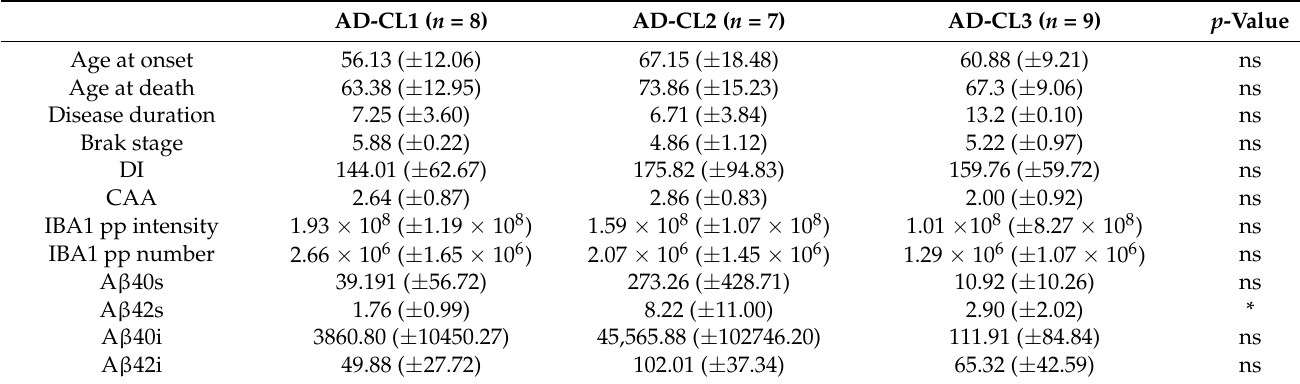
Figure 6. ( a ) Hierarchical Cluster Analysis (HCA) shows the different subgroups of AD patients characterized by different expression of neuroinflammatory molecular factors. In abscissa, there are the AD patients and the ordinate corresponds to the complete linkage measured by Euclidean distance. The dashed red line represents the cut off for three clusters (CL): AD-CL1 in yellow; AD-CL2 in red; AD-CL3 in light blue. ( b ) Histogram concerning the relative abundance of each inflammatory family (cytokines in red, chemokines in green, matrix-metalloproteinases (MMPs) in cream and Innate immunity factors in blue) within each cluster. Table 2. Cluster characterization. The table recapitulates the average for all the clinical, neuropathological and biological data available for each cluster. ± : standard deviation. DI: Dispersion Index, CAA: Cerebral Amyloid Angiopathy, A β 40s: A β 40 soluble levels, A β 42s: A β 42 soluble levels, A β 40i: A β 40 insoluble levels, A β 42i: A β 42 insoluble levels. Number and intensity of IBA1 are referred to positive pixel (pp) measurement. p -value calculated with Kruskal Wallis test. p < 0.05 *, ns = not